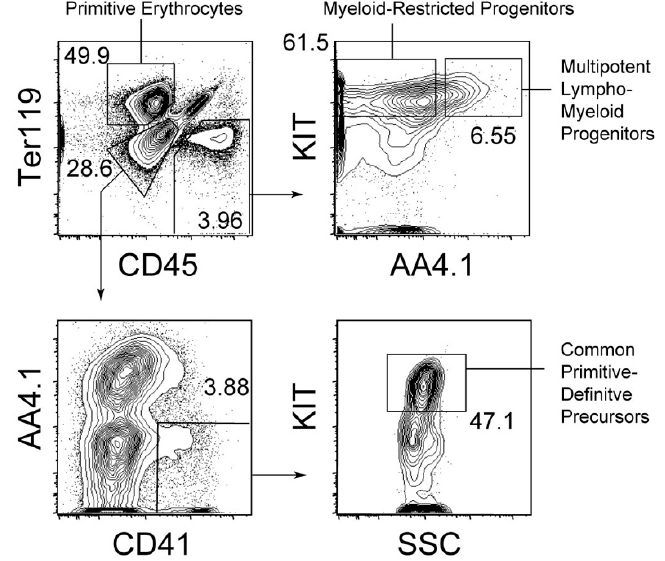
Figure 1. Hematopoietic cell fractions in the E9.5 yolk sac. Representative cell gating strategies to identify hematopoietic cell populations in the E9.5 yolk sac are shown. Numbers in plots indicate percentages of the cells in the gate within the parental cell fraction.